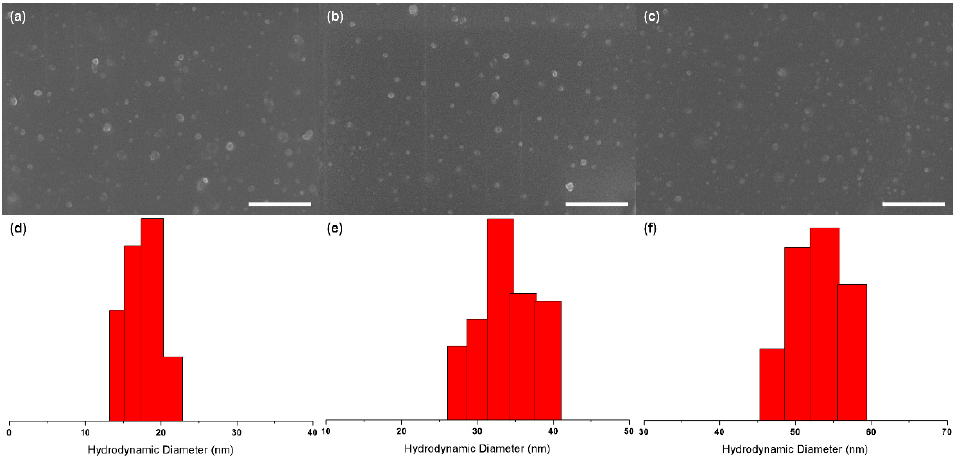
Figure 3. ( a–c ) FE-SEM images (scale bar, 500 nm) and ( d–f ) DLS plots of the self-assembled structures of DRBCPs in aqueous solution. ( a,d ) DRBCP1b. ( b,e ) DRBCP1c. ( c,f )